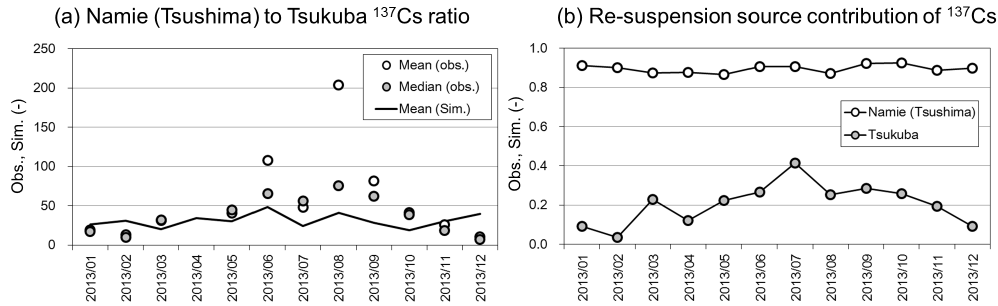
Figure 12. Monthly mean (a) observed mean, observed median and simulated Namie to Tsukuba 137 Cs concentration ratio and (b) simulated re-suspension source area (where the observed deposition amount >300kBqm − 2 ) contributions to 137 Cs air concentration at Namie and Tsukuba. The deposition parameters of the simulation in the figure are E c = 0.04 and v d = 0.1cms − 1